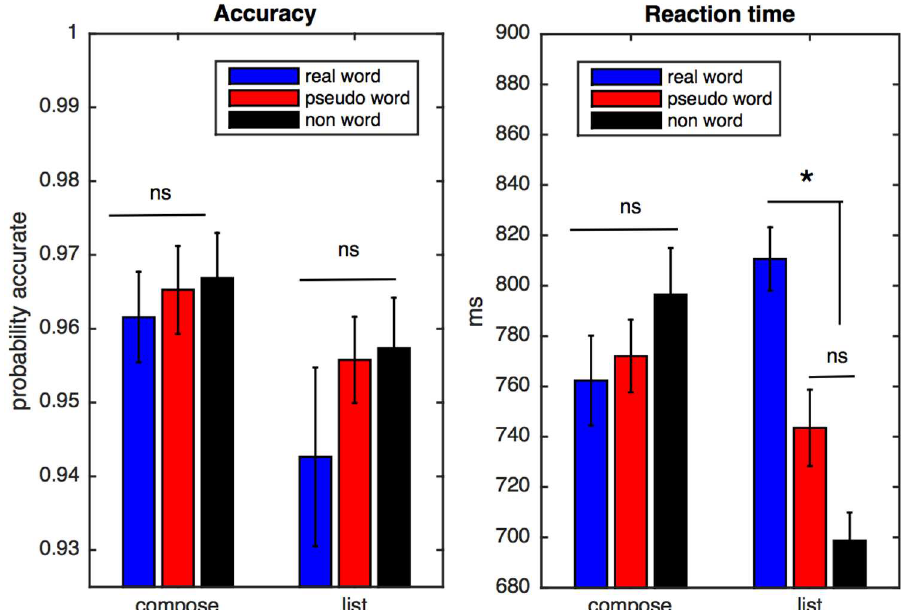
Fig 2. Behavioral data. Accuracy is shown in the left panel, and reaction time in the right panel. A significant effect of task was observed for accuracy, and a significant effect of conditionand a significant interaction between task and conditionwas observed for reaction